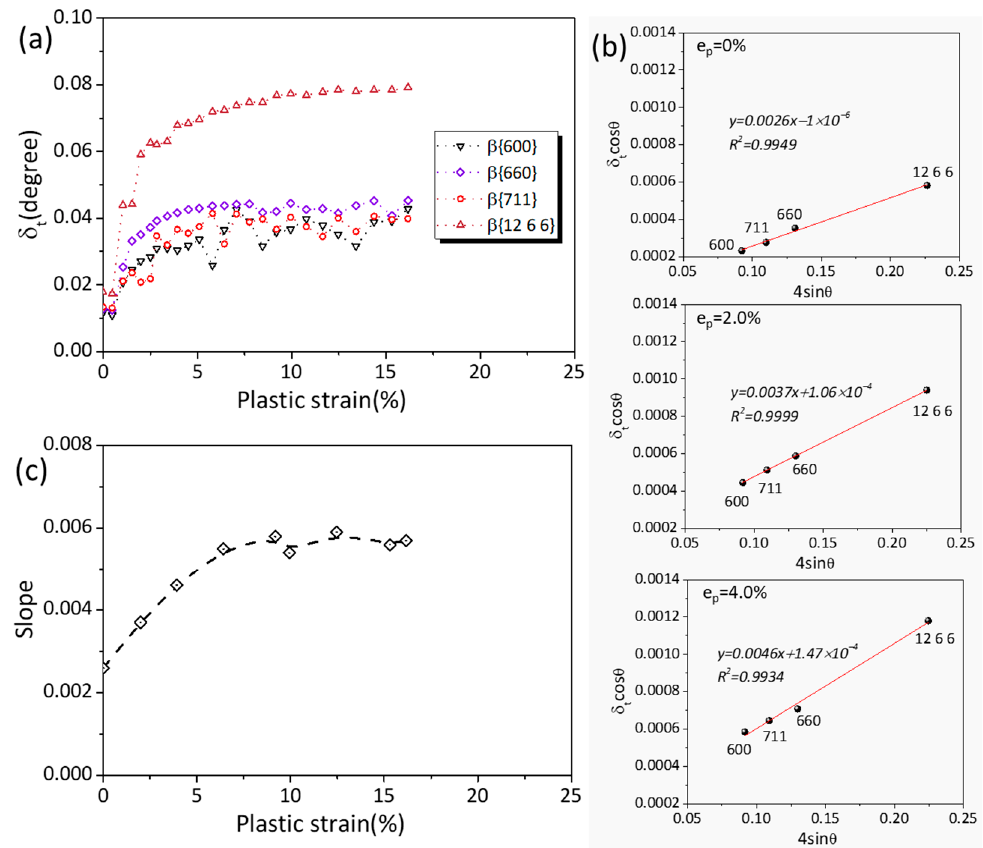
Figure 5. Diffraction peak analysis for the β phases. ( a ) Evolution of the measured FWHMs of the β peaks; ( b ) W–H plots for the β peaks at different plastic strains during the test. A strong variation in δ t cos θ as a function of 4sin θ can be seen. ( c ) W–H slope evolution of the β phases as a function of the plastic strain. The R ‐ square values of the linear fitting for W–H analyses were above 0.95.